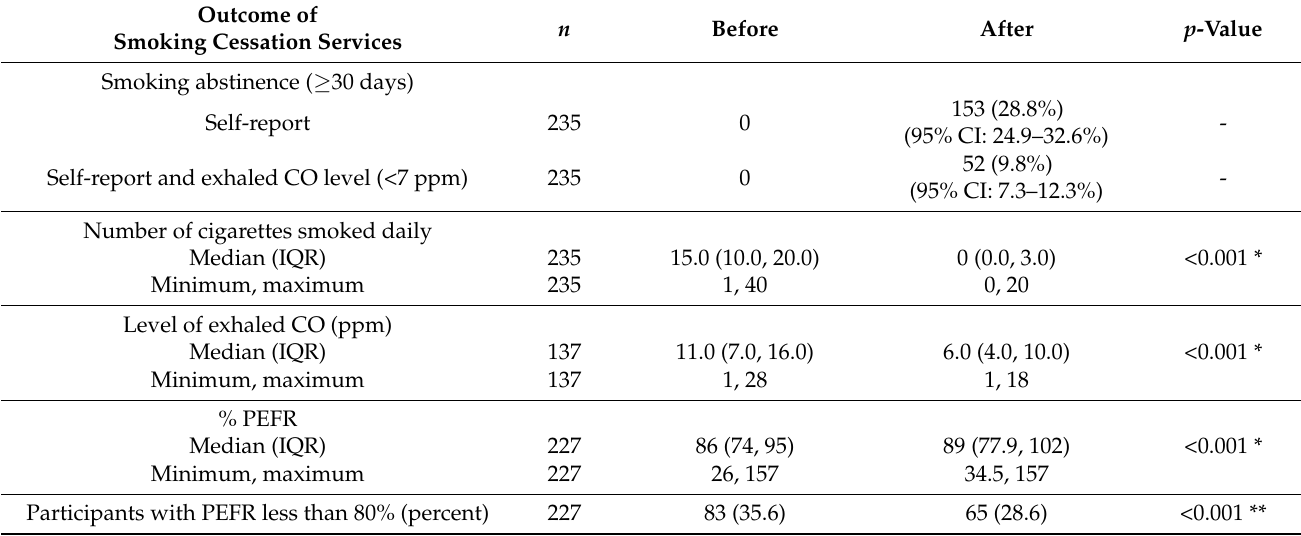
Table 2. Outcomes of smoking cessation services by the community pharmacy smoking cessation